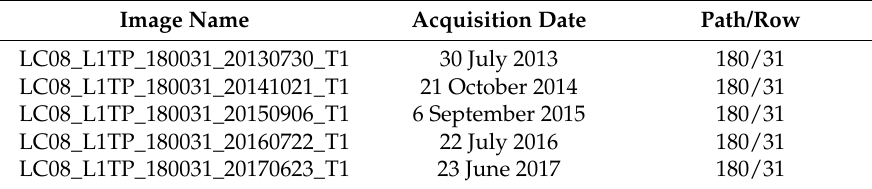
Table 1. Table 1. Specifications of the Landsat 8 OLI satellite images used in this Table 1. Specifications of the Landsat 8 OLI satellite images used in this study.